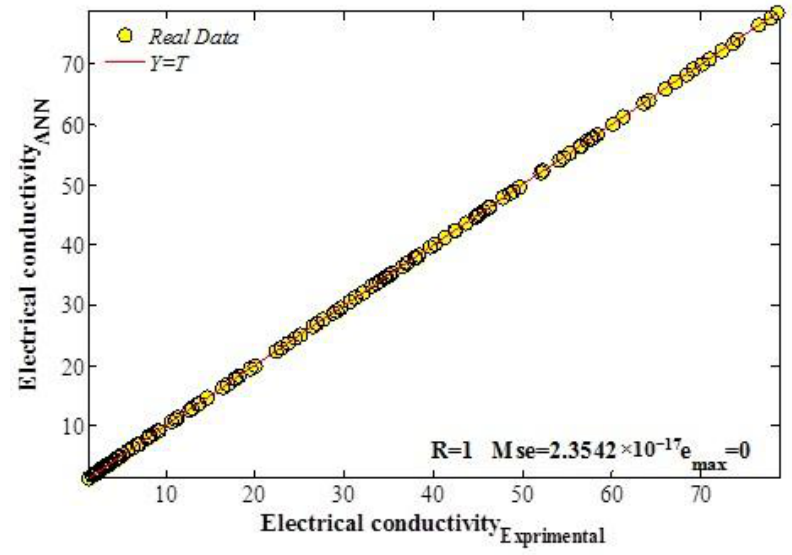
Figure 4. Comparison of the electrical conductivity predicted by the neural network and experimental results for all data in a network with 2 hidden layers and 31 neurons.